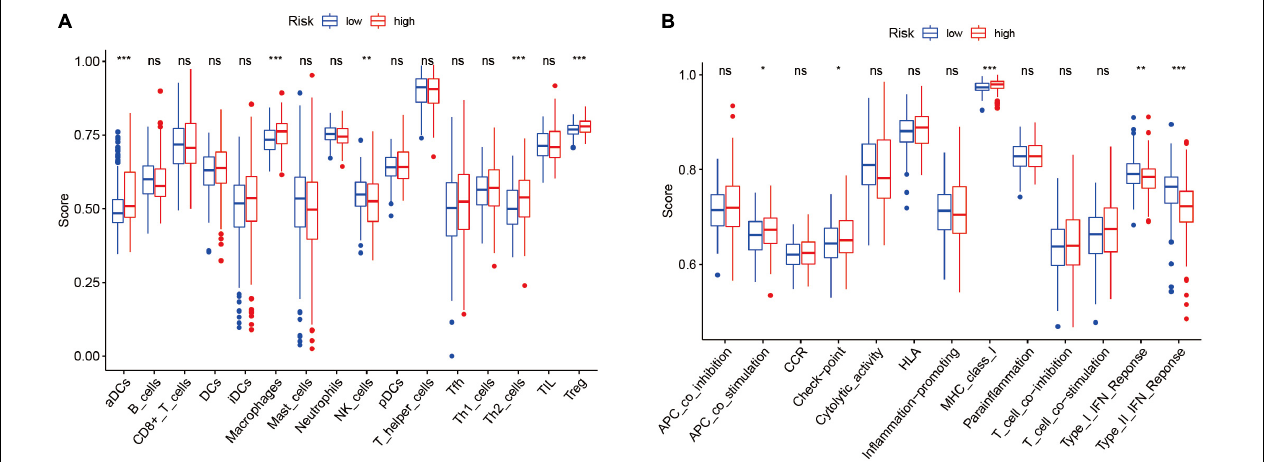
FIGURE 8 | The relationship between the risk score, immune infiltration cells, and immune functions based on ssGSEA. (A) Comparison of the infiltration levels of 16 immune cells between the low- and high-risk groups. (B) Comparison of the 13 immune functions between the low- and high-risk groups. ns: not statistically significant, * p < 0.05; ** p < 0.01; *** p < 0.001. ssGSEA: single-sample gene set enrichment